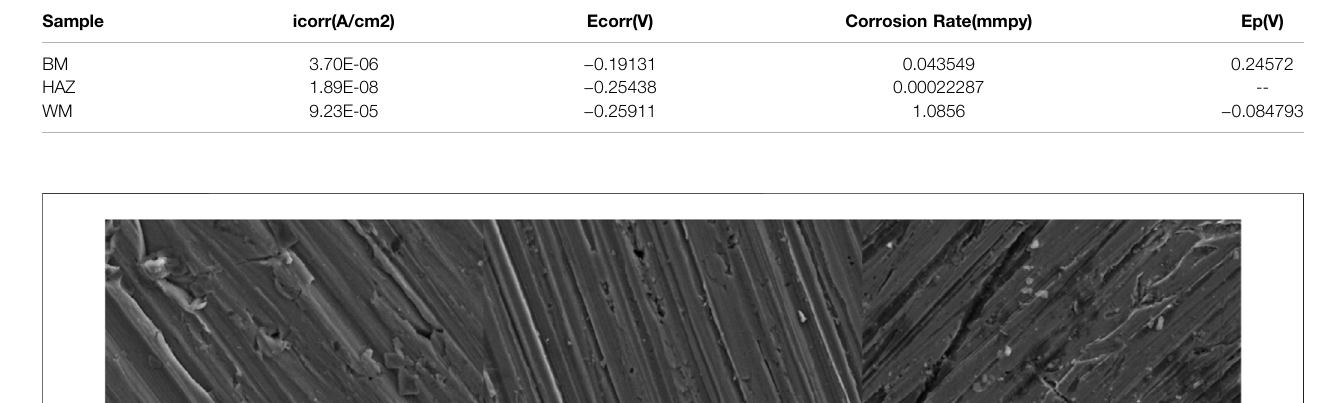
TABLE 14 | Polarization fi tting data of the three regions at 45 °